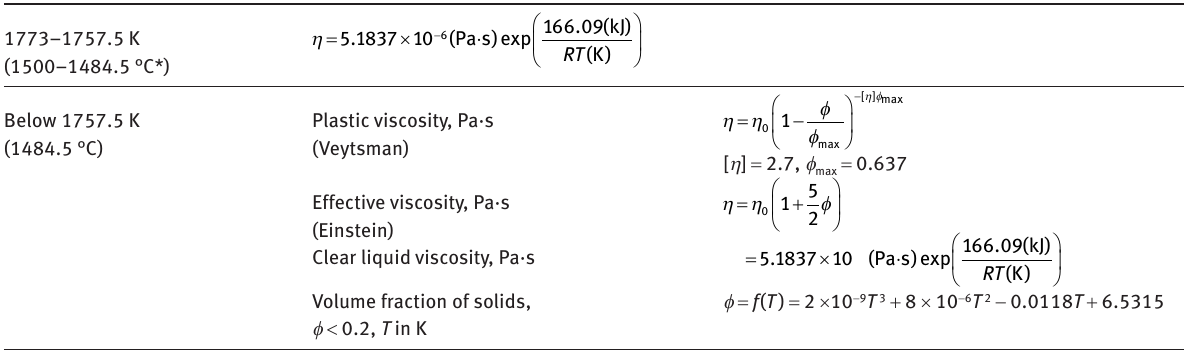
Figure 8. A discussion of the formation kinetics of anor­ thite is beyond the scope of this study. For all blend chem­